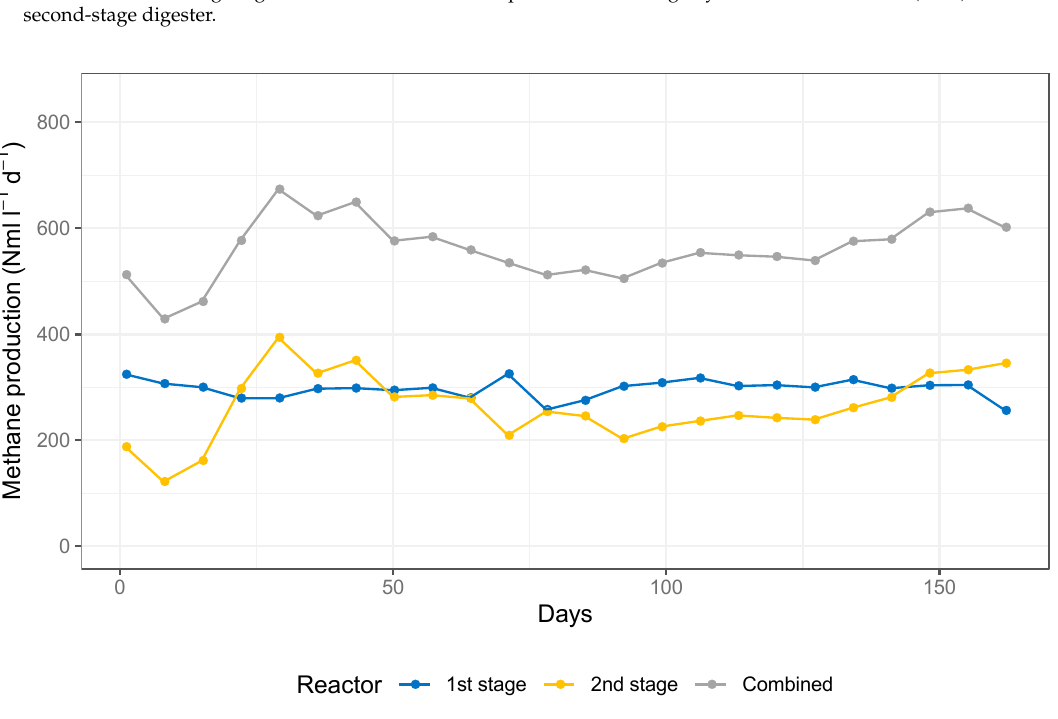
Figure 5. Volumetric methane production (weekly averages) for the sequential Salix co-digestion process. Days are relative to the start of the sequential digestion experiment.